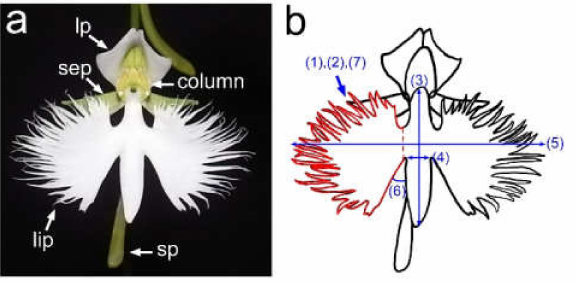
Figure 1. ( a ) H. radiata flower. Note: lip, lip (or labellum); lp, lateral petal; sep, sepal; sp, spur. ( b ) Seven measurement factors used to quantify the lip shape: (1) area, (2) perimeter, (3) body length, (4) body width, (5) wing length, (6) angle between body and wing, and (7) serration